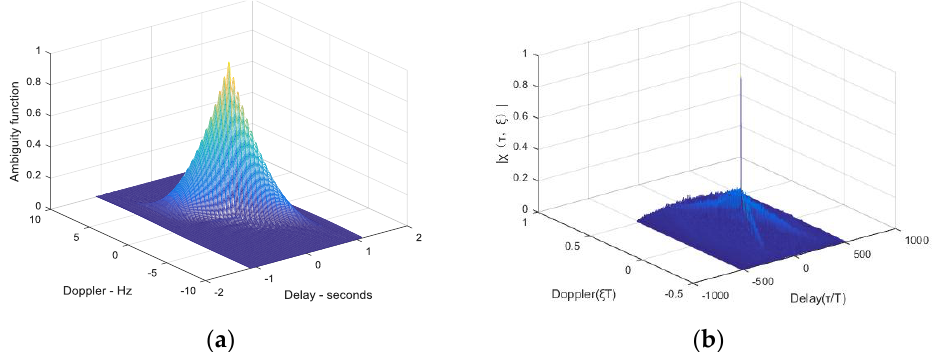
Figure 3. ( a ) Ambiguity function of LFM signal; ( b ) ambiguity function of VFM signal.